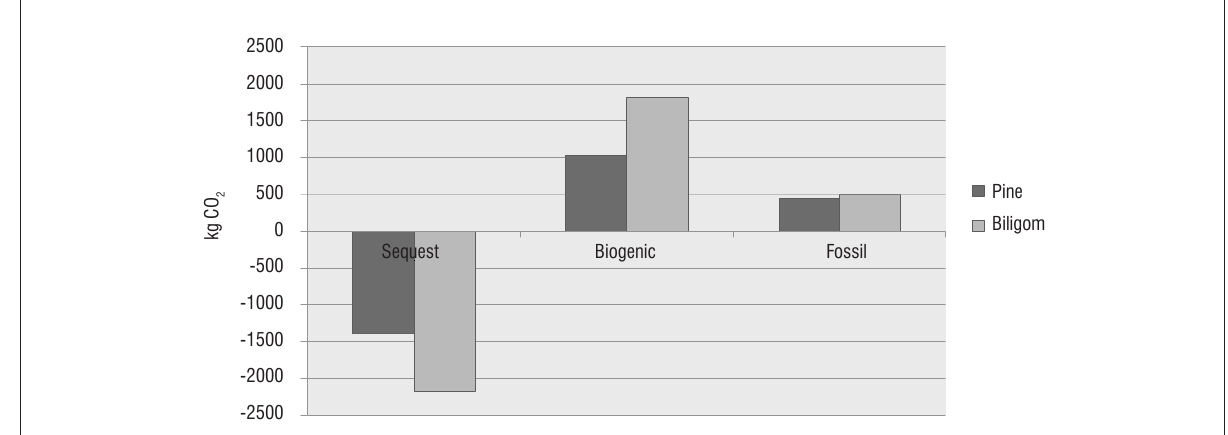
Figure 2: Carbon dioxide flow of South African pine and Biligom for the 42-m 2 roof design.